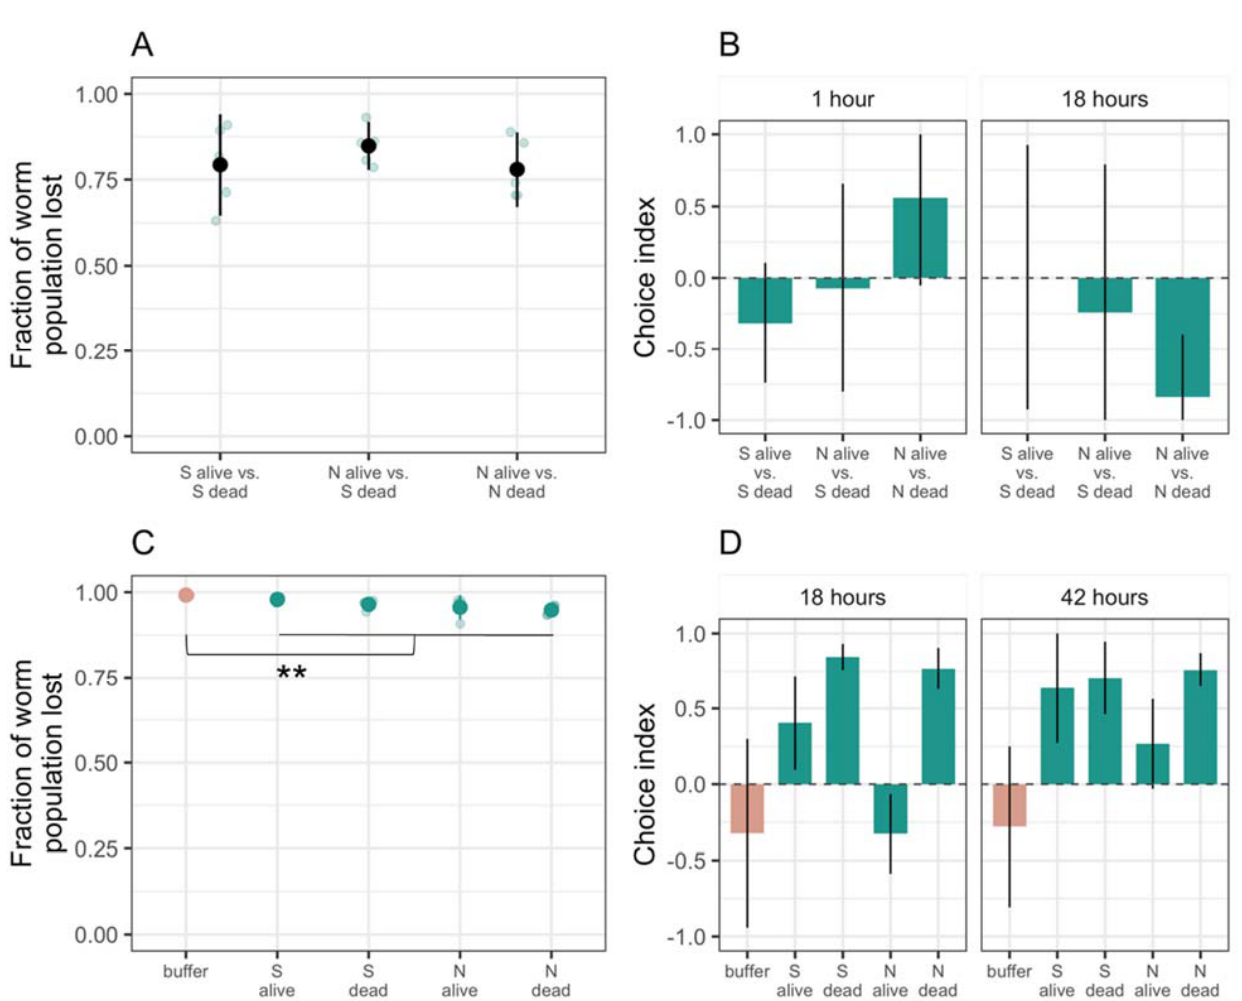
Figure 2. C. elegans prefers M. xanthus to buffered agar. We tested potential effects of living or dead M. xanthus on the position of worms presented with choices between either two circular patches of M. xanthus ( A , B ) or between a half-plate lawn of M. xanthus versus a half plate of bacteria-free agar ( C , D ). For both experiments, we report the mean fraction of C. elegans populations that left the plate ( A , C ) and the choices made by the worms that remained on the plate ( B , D ). In panel B, positive vs. negative values reflect attraction to the first- vs. second-listed type of bacteria, respectively. In panel D, positive vs. negative values reflect attraction to the inoculated vs. uninoculated half of the plate, respectively. Each large dot is the mean of five biological replicates (shown as transparent blue dots). Error bars represent 95% confidence intervals. In some instances ( B ), 95% confidence intervals extend outside the range of what is biologically possible, [ − 1,1], so we restricted them to reflect the biological reality. ** p < 0.01.